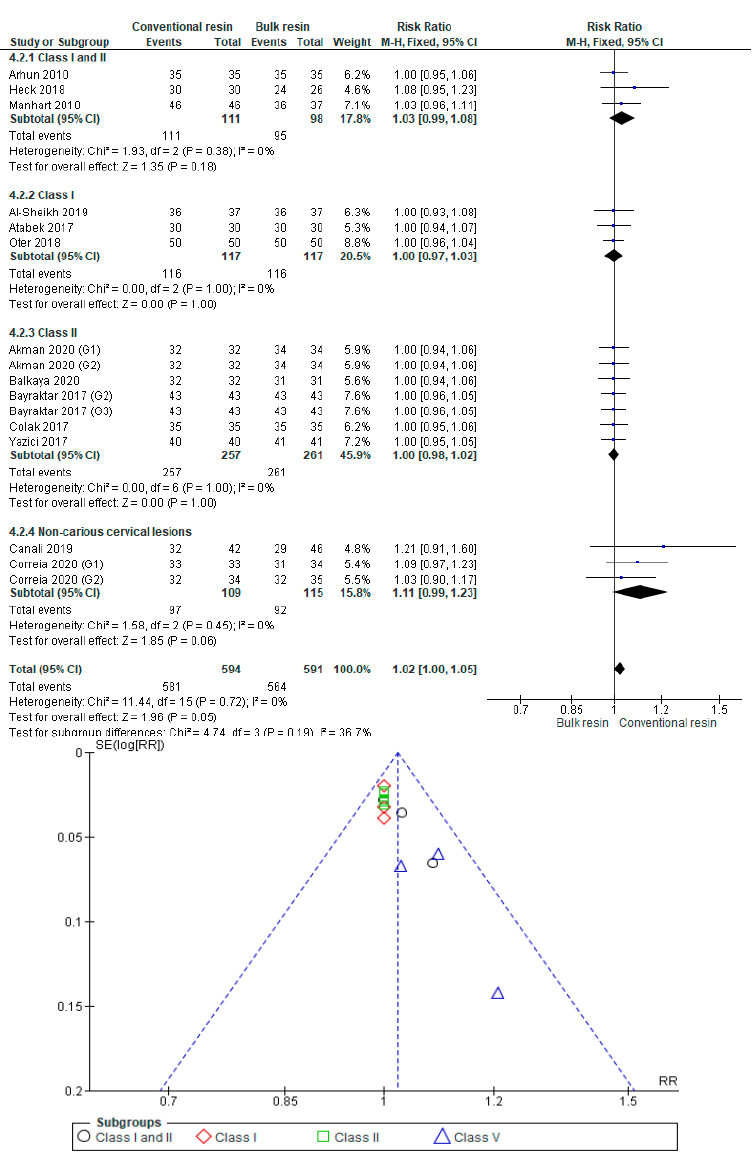
Figure A17. Absence of Post-Operative Sensitivity: Conventional Resin versus Bulk Resin According to Type of Restoration.